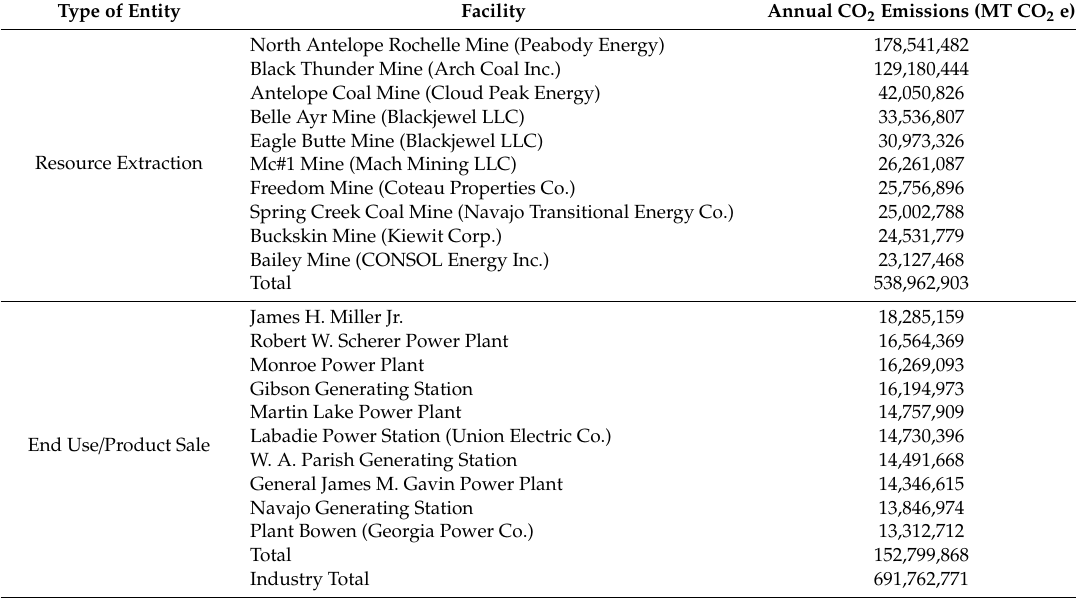
Table A5. Top CO 2 Bottlenecks of the Coal Industry for Resource Extraction and